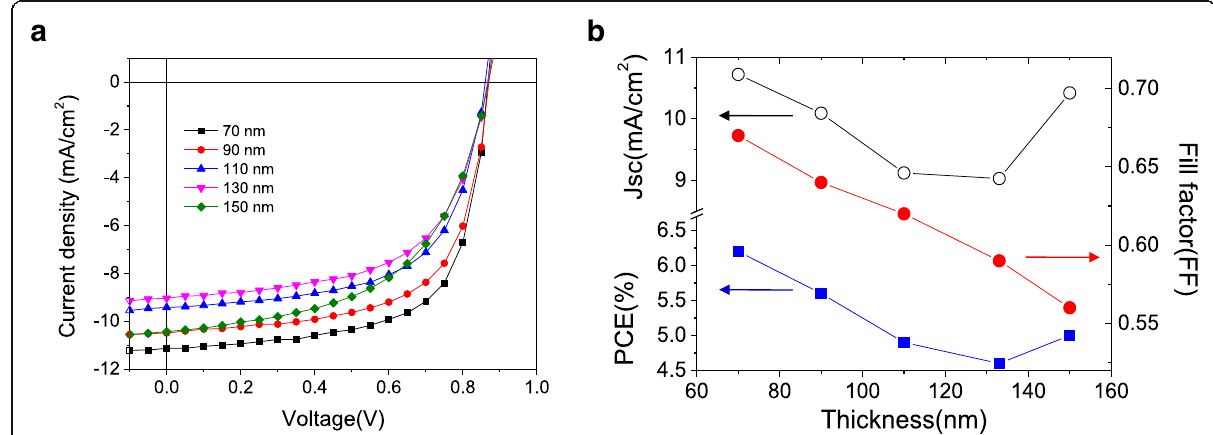
Fig. 2 a J-V characteristics of BHJ devices with AM 1.5G light condition and b figures of merit for different active layer thickness